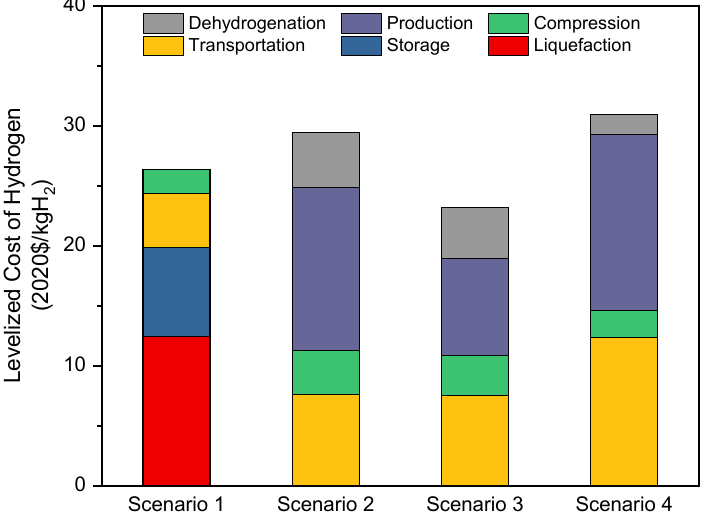
Figure 4. TEA analysis